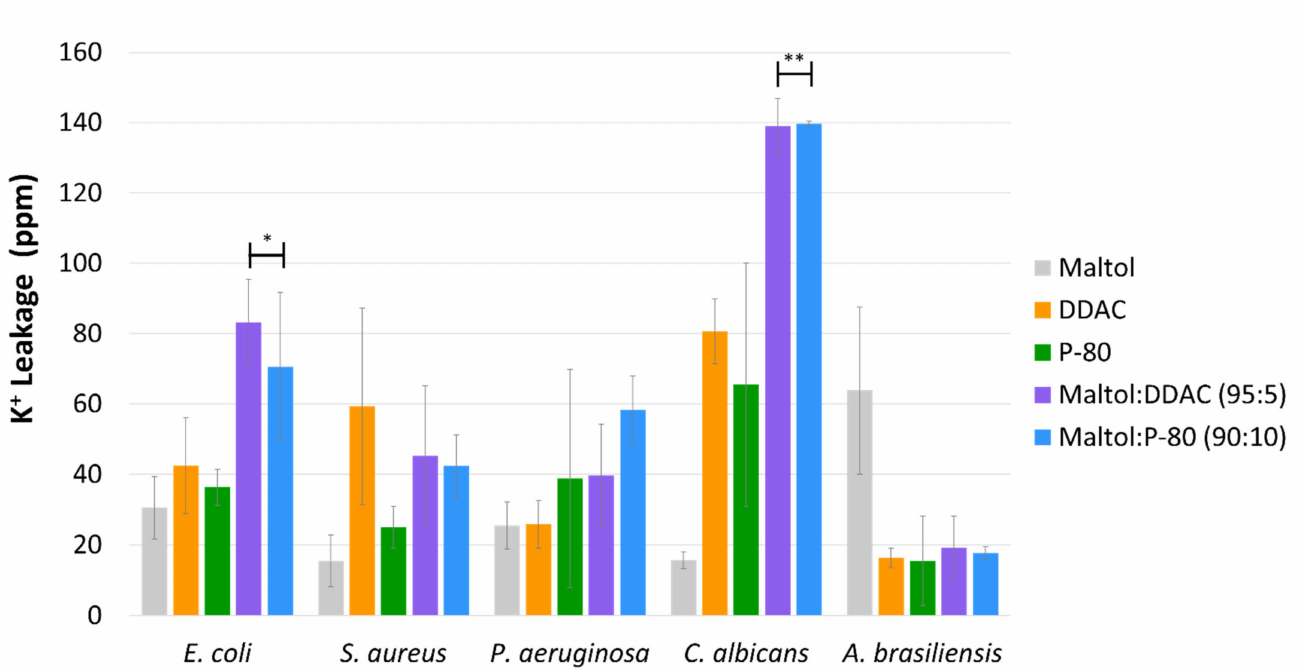
Figure 5. The average potassium leakage from the five pharmacopeia microorganisms, E. coli , S. aureus , P. aeruginosa , C. albicans, and A. brasiliensis , in response to maltol, DDAC, P-80, maltol:DDAC blend (95:5), and maltol:P-80 blend (90:10), by using a single chosen concentration, which elicited the highest response. Results are presented as ppm of potassium cations measured using emission flame photometry. Data are based on three independent experiments and represented as the average potassium leakage (ppm) ± SD. Significant differences are indicated as; * ( p < 0.05) and ** ( p < 0.01), using